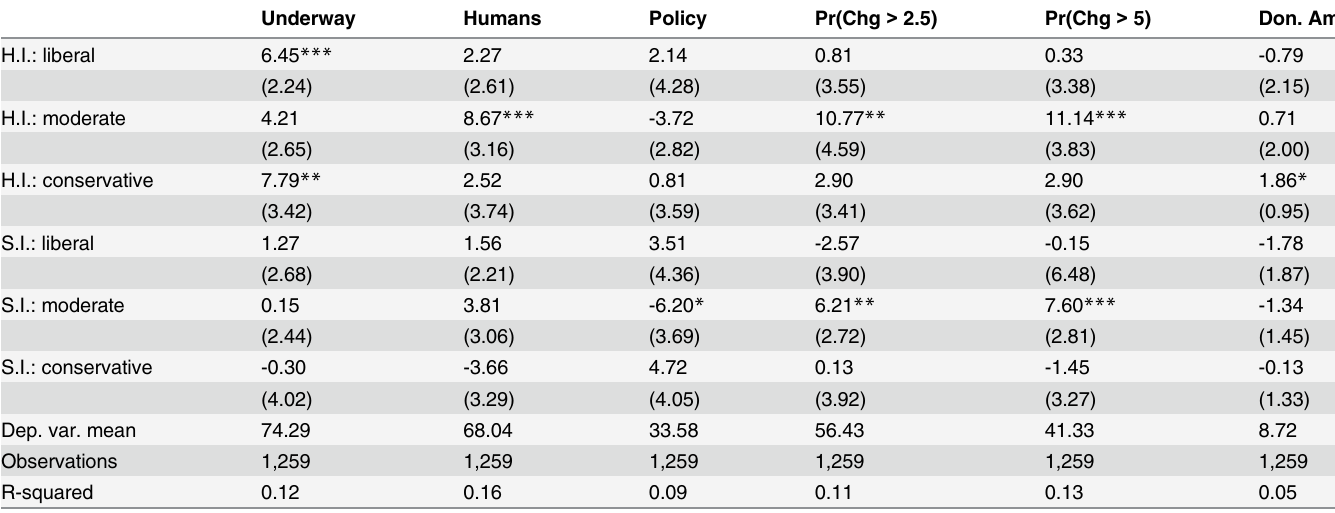
Table 3. Short-run effects of information by